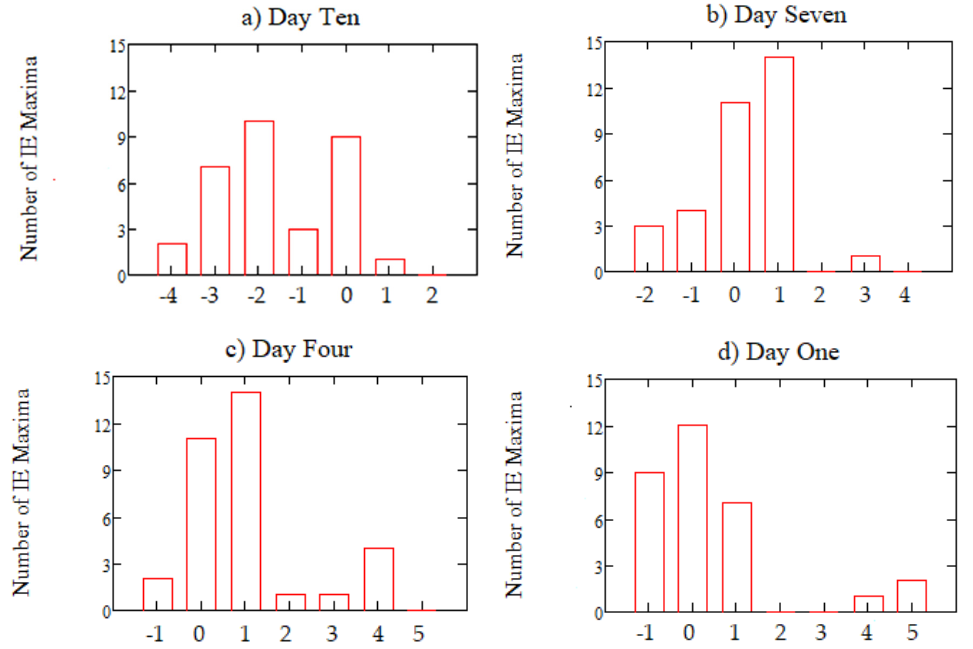
Figure 4. The ( a ) ten, ( b ) seven, ( c ) four and ( d ) one day NAEFS ensemble mean IE forecast prior to an observed IE maximum associated with regime transition. The ordinate is the number of model forecasts and the abscissa is the number of days prior ( − ) or following (+) the model forecast local IE maximum was from the observed IE maximum.